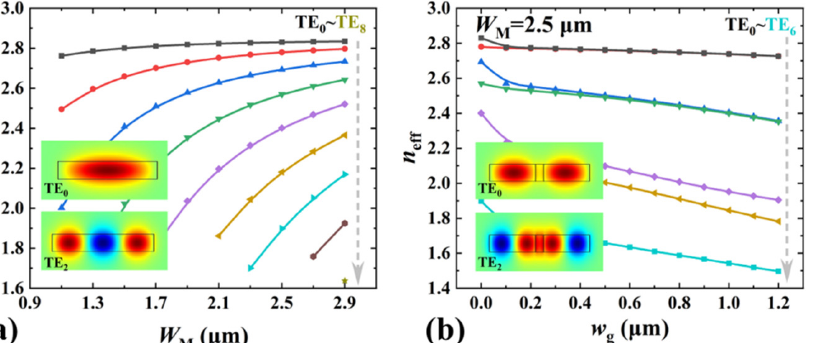
Figure 2. ( a ) Effective indices n eff of guided modes as a function of the waveguide width for the TE polarization state. Insets show the electric field distributions of TE 0 and TE 2 modes. ( b ) Effective indices n eff of guided modes for the multimode waveguide embedded with the central SWG structure as a function of the SWG width w g . The multimode waveguide width was chosen as W M = 2.5 μ m. Insets show the electric field distributions of TE 0 and TE 2 modes.